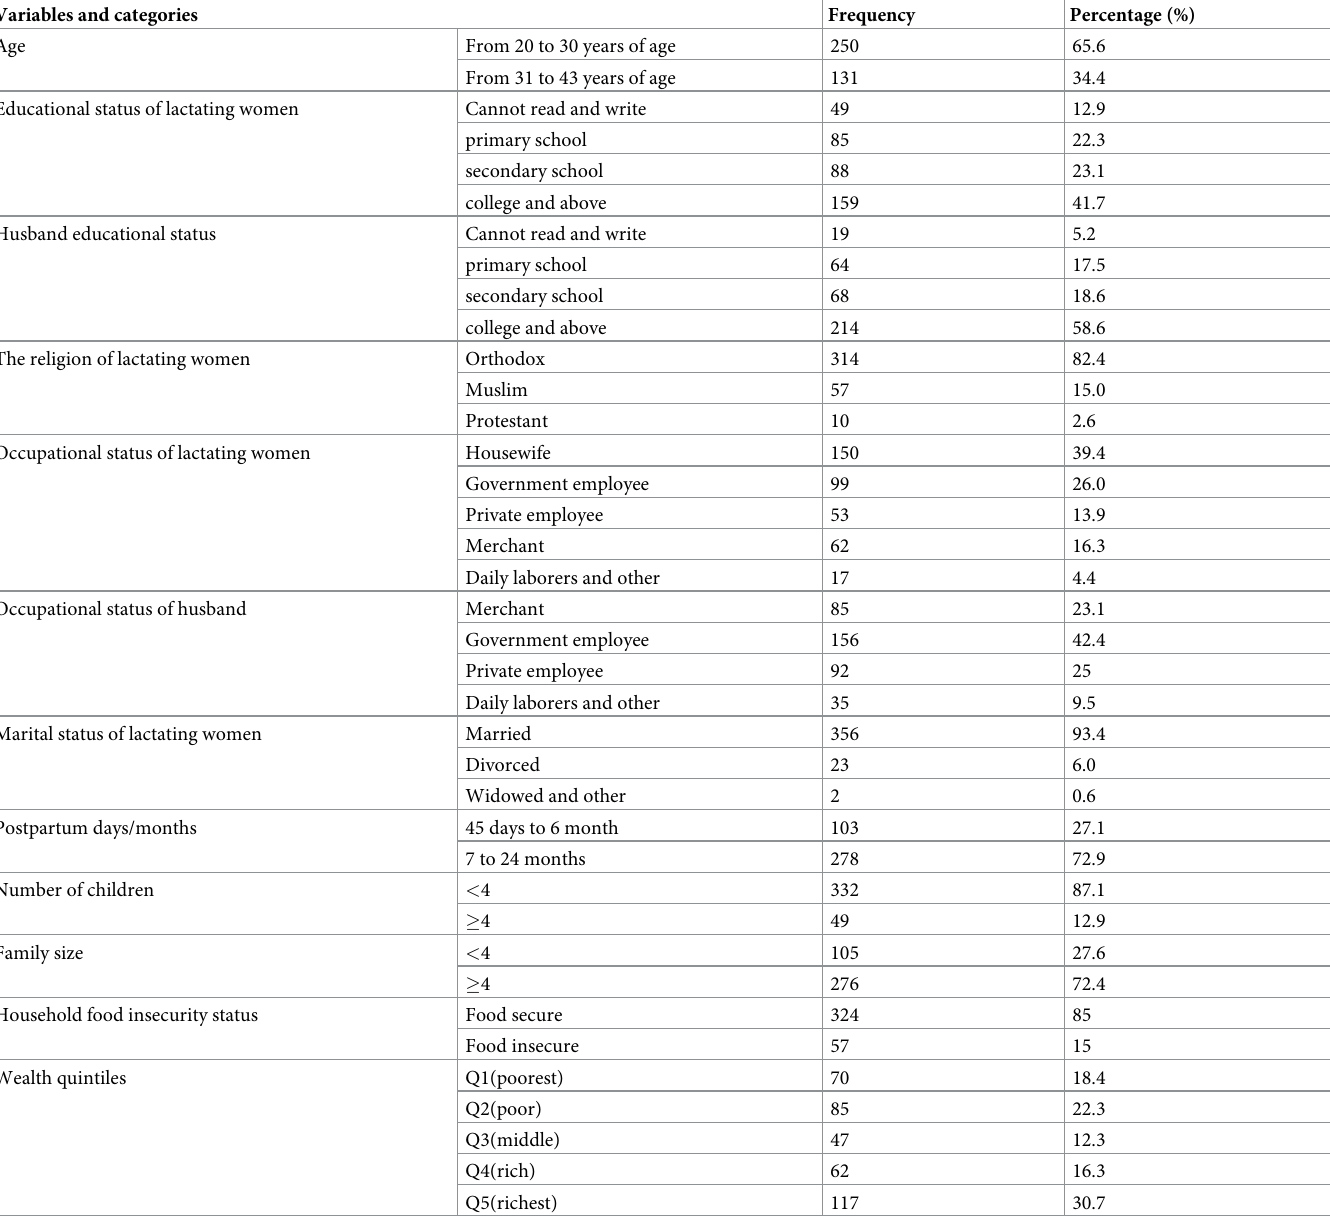
Table 1. Socio-demographic and socio-economic characteristics of lactating women in Bahir Dar city, Northwest Ethiopia, 2021(n = 381). Variables and